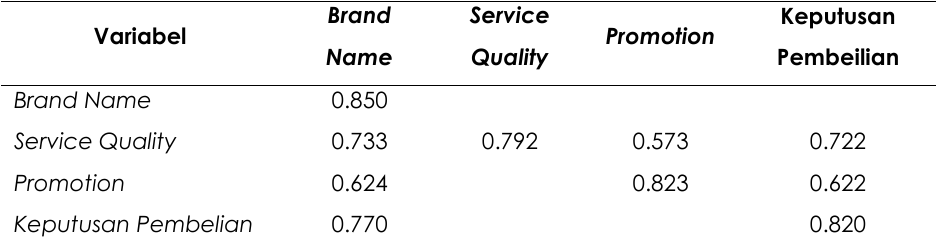
Tabel 6. Discriminant Validity Results